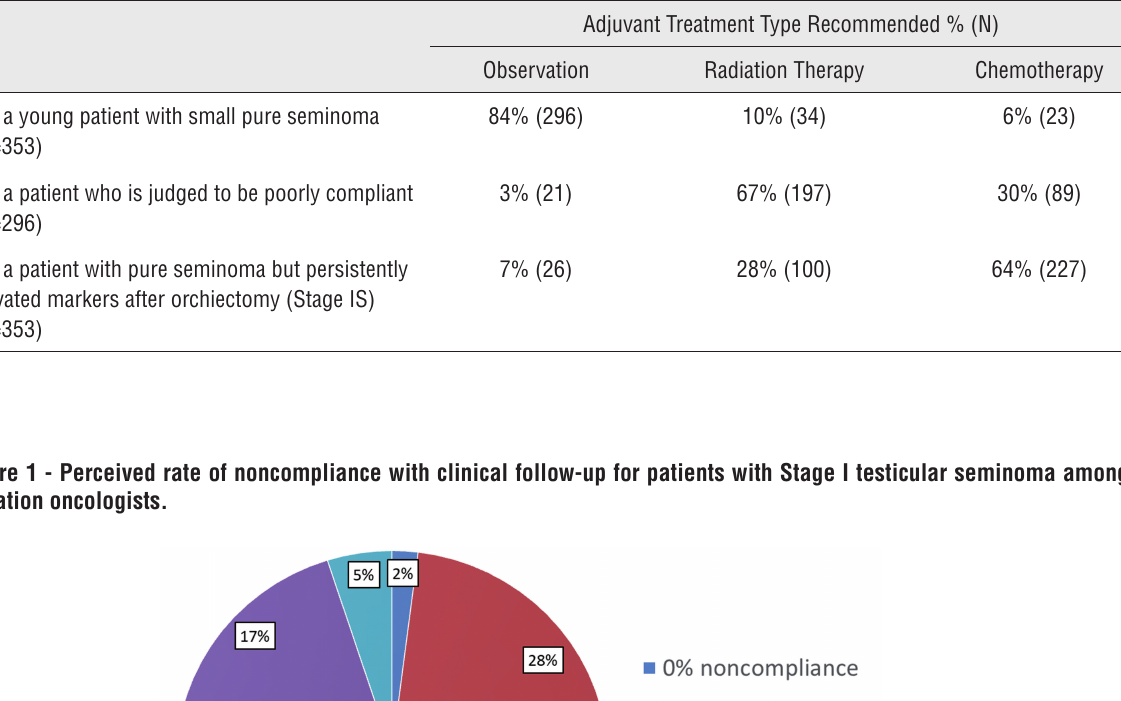
Table 2 - Adjuvant treatment recommendations for patients with stage i testicular seminoma.